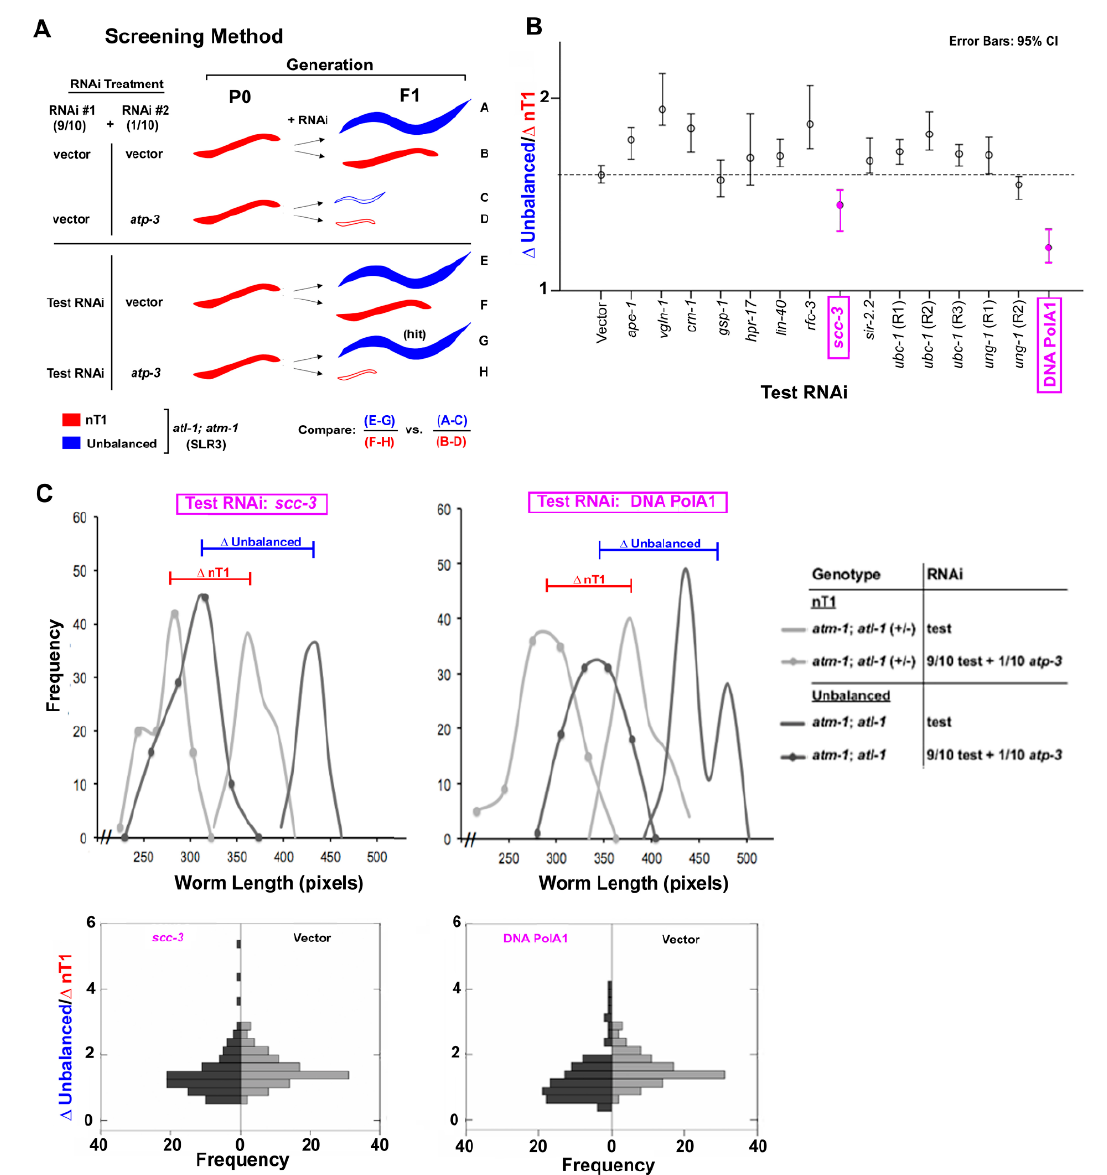
Figure 3. Screen for additional checkpoint proteins activated by mitochondrial ETC dysfunction . ( A ) Schematic of RNAi screen used to identify DNA damage response genes active in atl-1(tm853) ; atm-1(gk186) double mutants following atp-3 knockdown. Test RNAi that differentially countered the size-reducing effect of 1/10th strength atp-3 RNAi in unbalanced atl-1(tm853) ; atm-1(gk186) worms, but not nT1-containing atl-1(tm853) ; atm-1(gk186)/+ worms, were sought (hit). ( B ) Results of RNAi screen. The effect of each test RNAi on the length of unbalanced worms and nT1-containing worms in the presence and absence of 1/10th strength atp-3 RNAi is reported as a mean difference ratio. The 95% confidence interval (CI) for each ratio is shown. RNAi knockdown of scc-3 and Y47D3A . 29 (labeled DNA PolA1) both significantly reduced the mean ratio relative to vector-only test RNAi ( p < 0.001, see Methods for significance testing procedure). ( C ) Top row: Size distribution of worm populations treated with scc-3 (left) or Y47D3A . 29 (right) feeding RNAi. Bottom row: Histo- grams of mean difference ratios for worm populations treated with scc-3 (left) or Y47D3A . 29 (right) feeding RNAi, and plotted relative to worms treated with vector in place of test RNAi. Mean differ- ence ratios were generated by random sampling from the distributions in the top row .